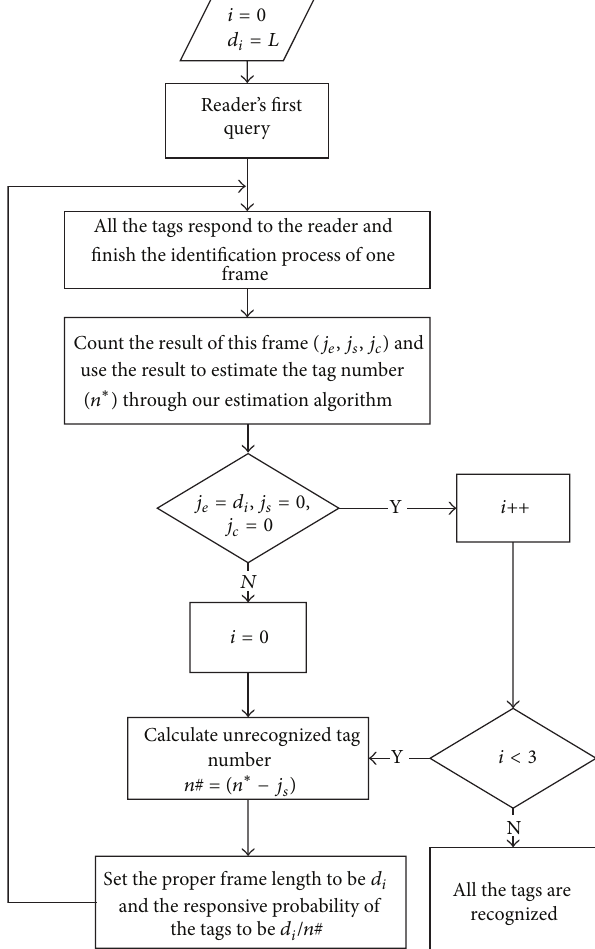
Figure 2: Process of the whole